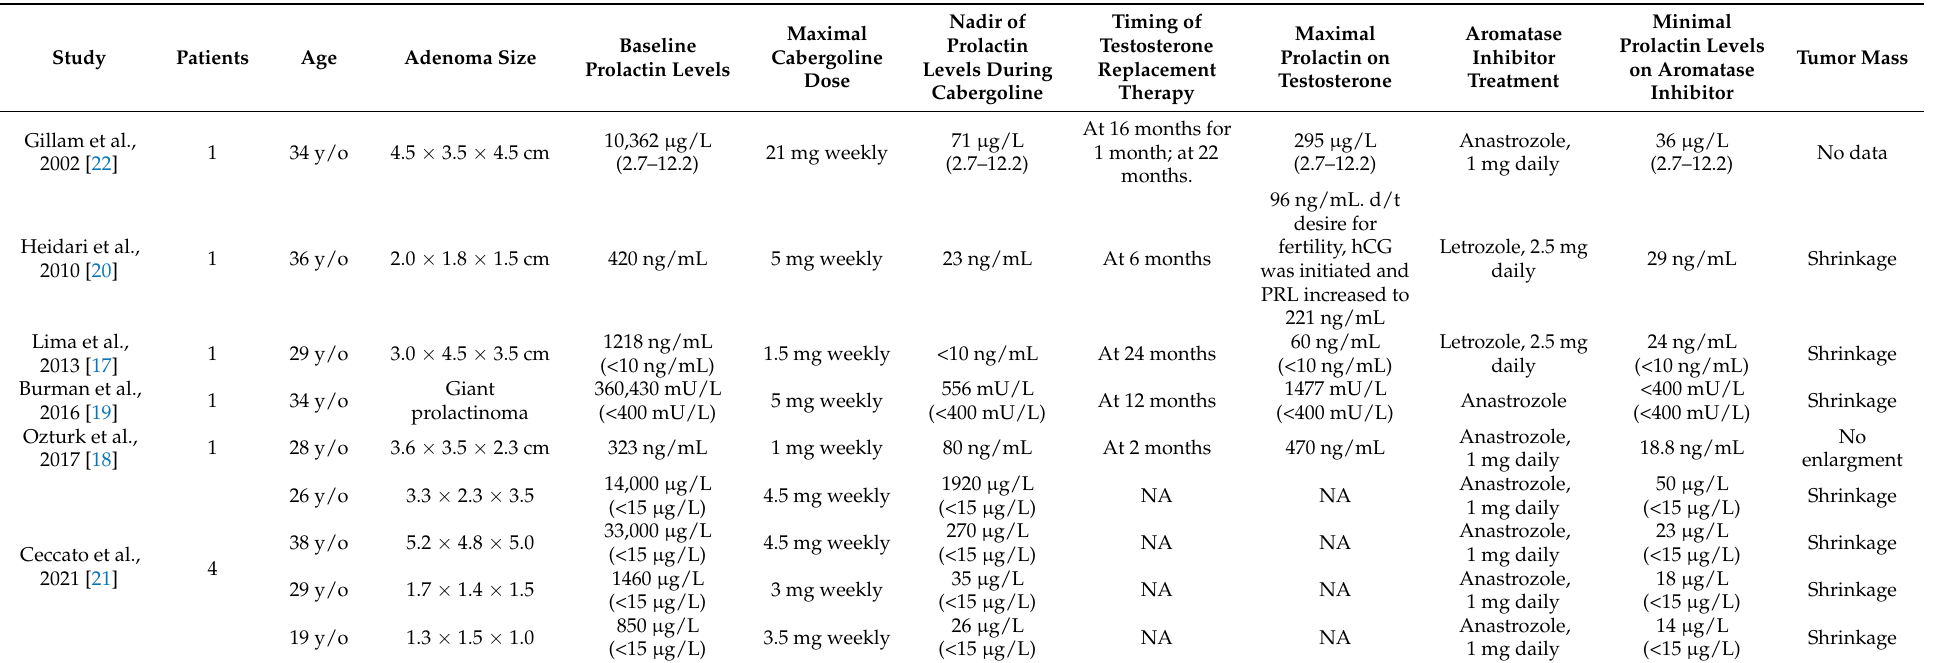
Table 1. Systematic review: summary of available data. Previously conducted case reports and case-series on the use of aromatase inhibitors for male patients with